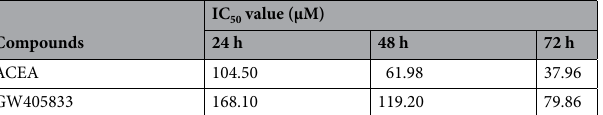
Table 1. The estimated IC 50 values of ACEA and GW405833 on UMR-106 cell viability. The IC 50 values were calculated using a nonlinear regression model from results in Fig. 2 by GraphPad Prism 9.1.2.